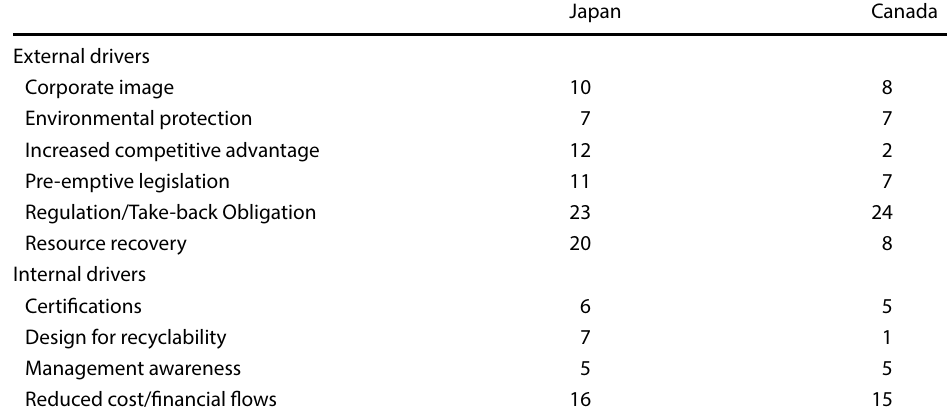
Table 6 External and internal barriers: incidence of codes compared between Japanese and Canadian